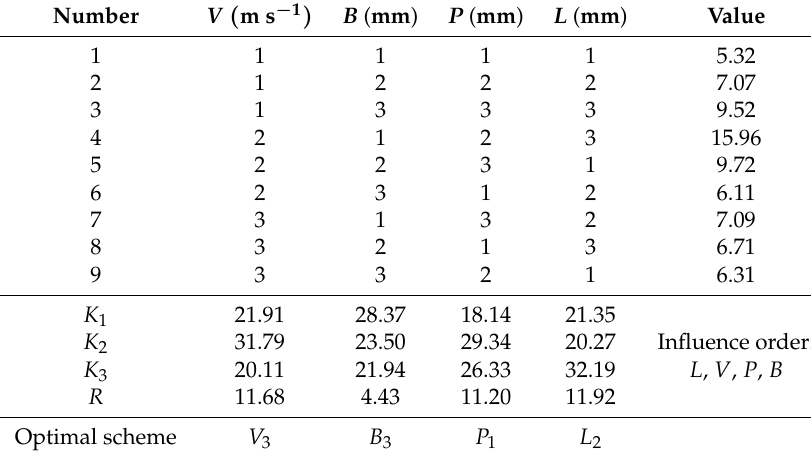
Table 5. Simulation results of index S